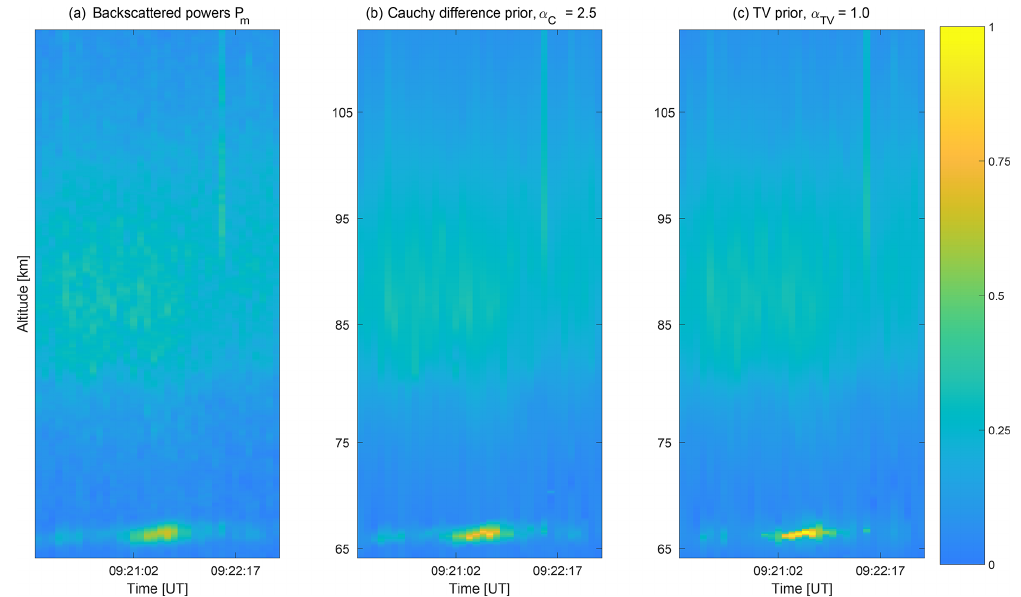
Figure 7. PMWE time series of backscattered power profiles after matched filtering (a) , Cauchy difference prior for α C = 2 . 5 (b) , and TV prior with α TV = 1 . 0 (c)